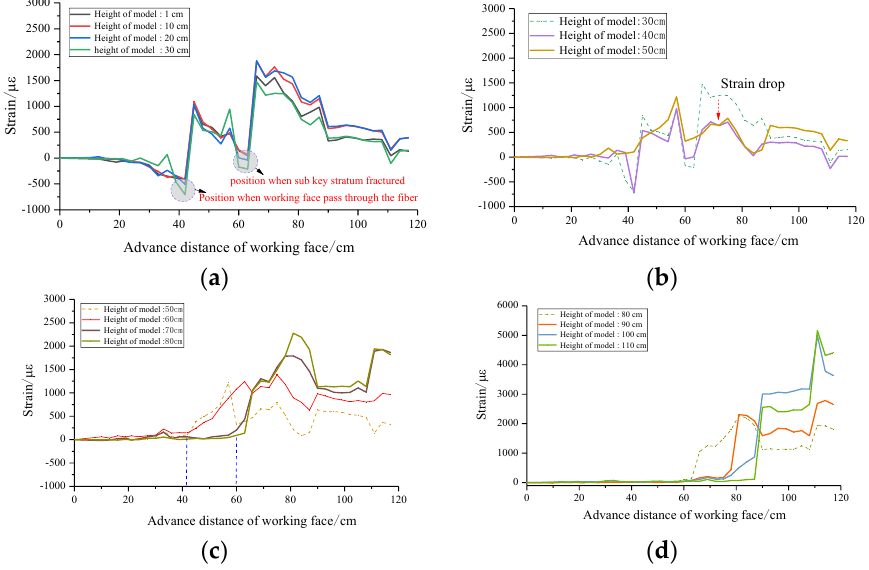
Figure 9. Strain distribution characteristics of rock mass detected with optical fiber at different heights. ( a ) Floor region and caving zone. ( b ) Top airspace area. ( c ) Mining-affected area under main key stratum. ( d ) Mining-affected area above main key stratum.